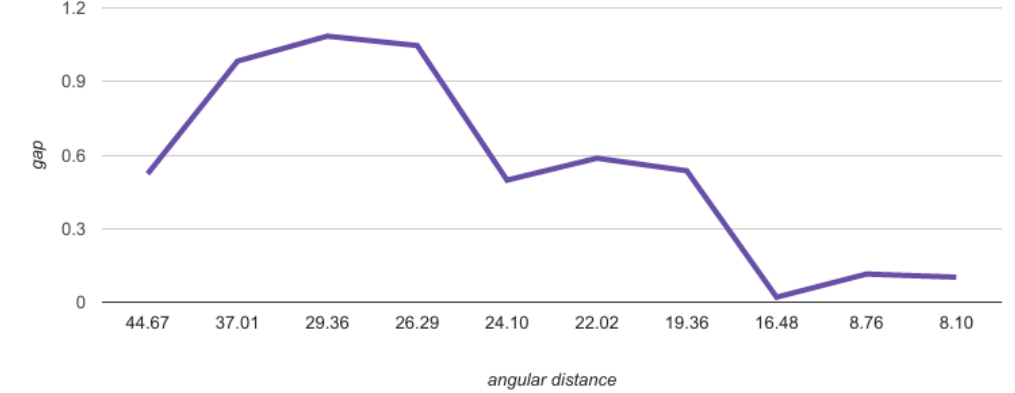
Figure 10. Angular distance gap between two stars in the ratio of its